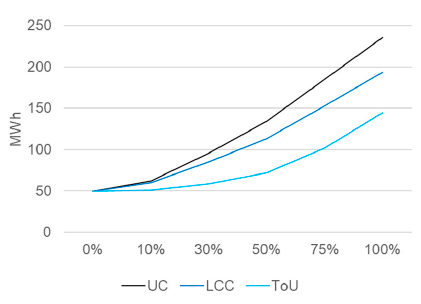
Figure 12. Development of the building’s maximum demand.